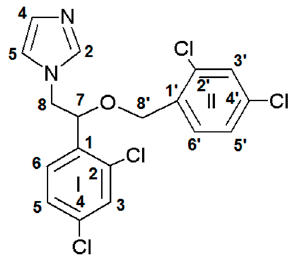
Figure 1. Chemical structure of miconazole.